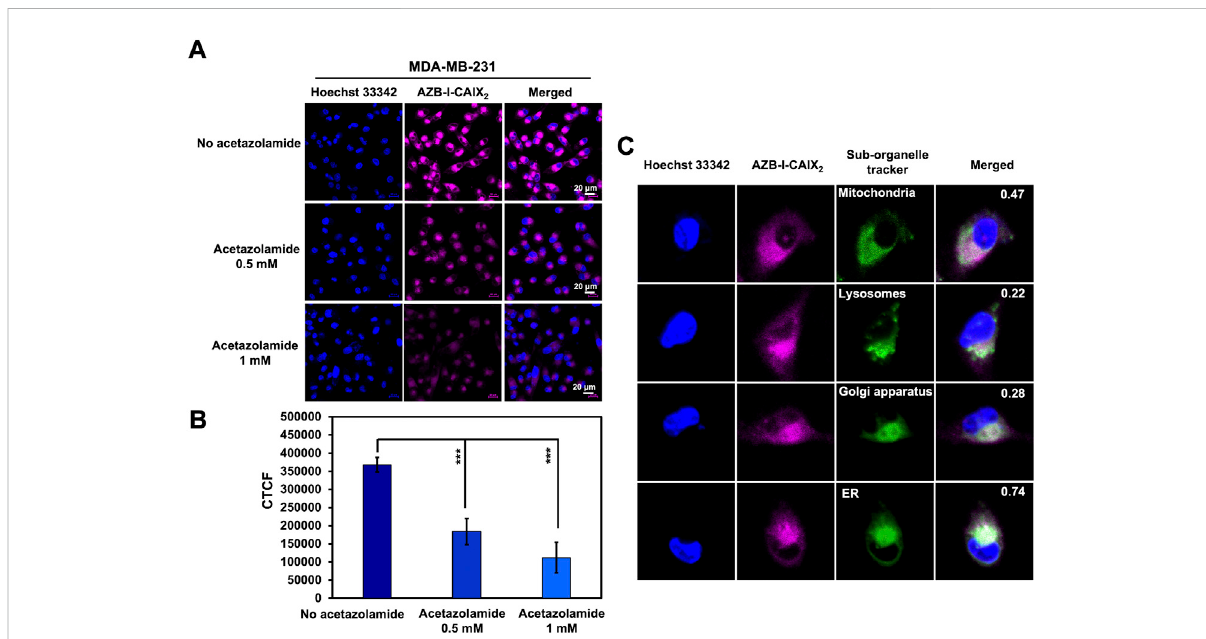
Inhibitory effect of CAIX inhibitor (acetazolamide) on the cellular uptake of AZB-I-CAIX 2 . (A) Confocal images of MDA-MB-231 cells incubated with AZB-I-CAIX 2 (5 μ M) in the absence and presence of acetazolamide (0.5 mM and 1.0 mM) for 6 h. (B) Corrected Total Cell Fluorescence (CTCF) of signals from experiment (A) (C) Colocalization of AZB-I-CAIX 2 with organelle trackers (MitoTracker, LysoTracker, Golgi and ER markers) in MDA-